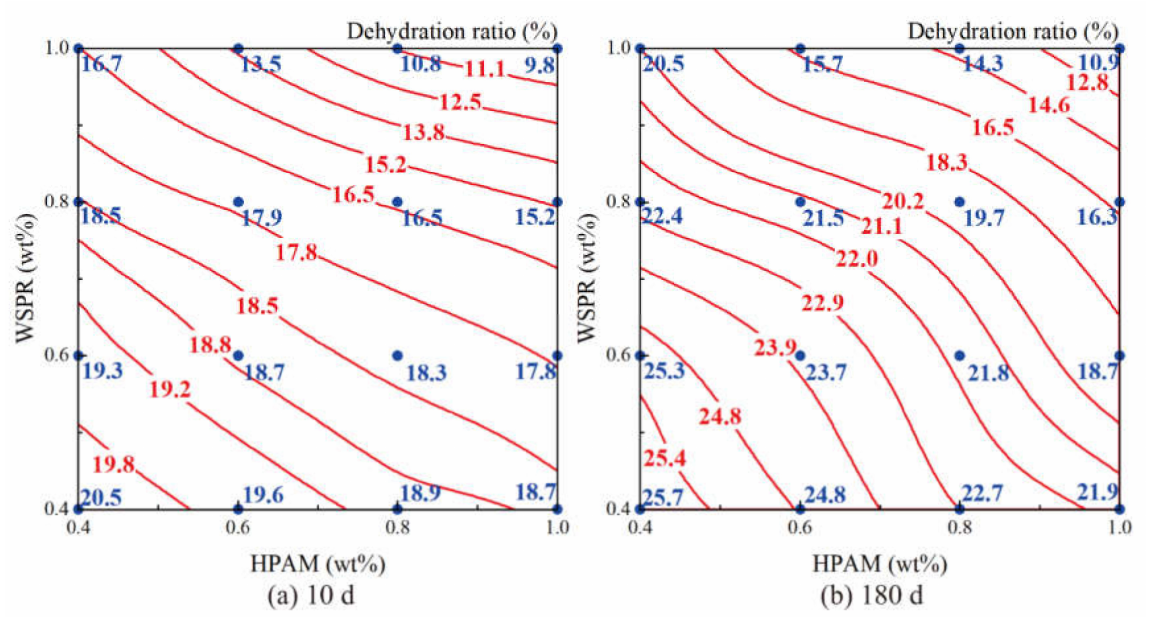
Figure 5. Dehydration ratio isogram of different component gels after aging at 110 ◦ C for different times: ( a ) Dehydration ratio of gels aged at 110 ◦ C for 10 days; ( b ) Dehydration ratio of gels aged at 110 ◦ C for 180